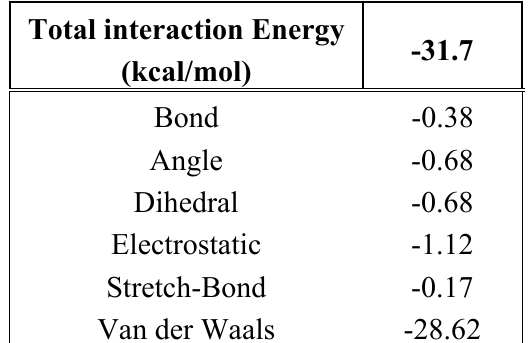
Table 2. Partial energy contributions to total complex interaction energy (kcal/mol).